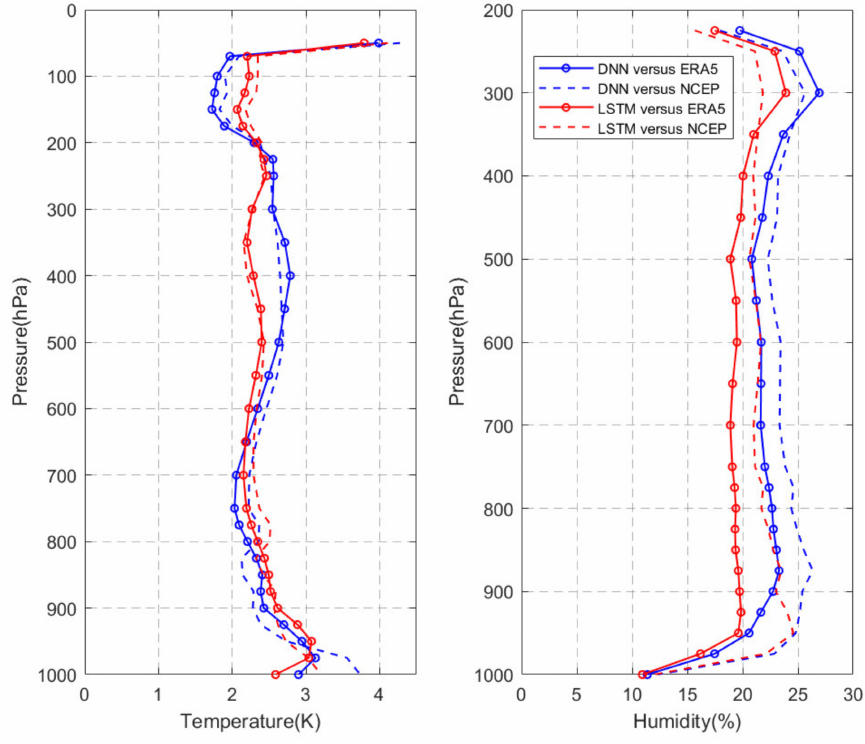
Figure A1. The retrieval RMSEs of the DNN-based model and LSTM-based model with respect to ERA5 and NCEP reanalysis data over sea ice in April 2021.